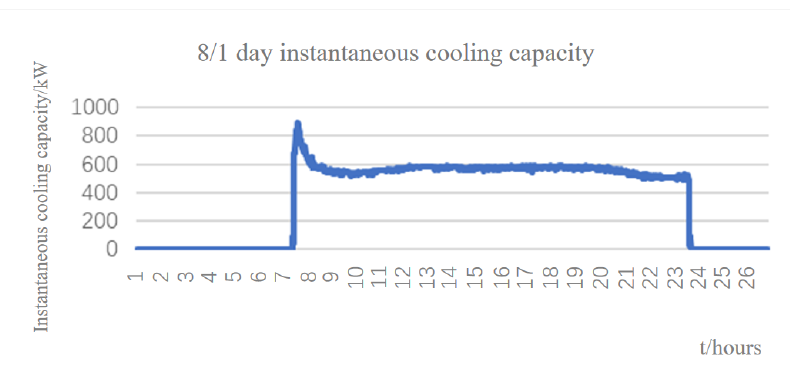
Figure 8. Cooling capacity per min on 1 August 2020.